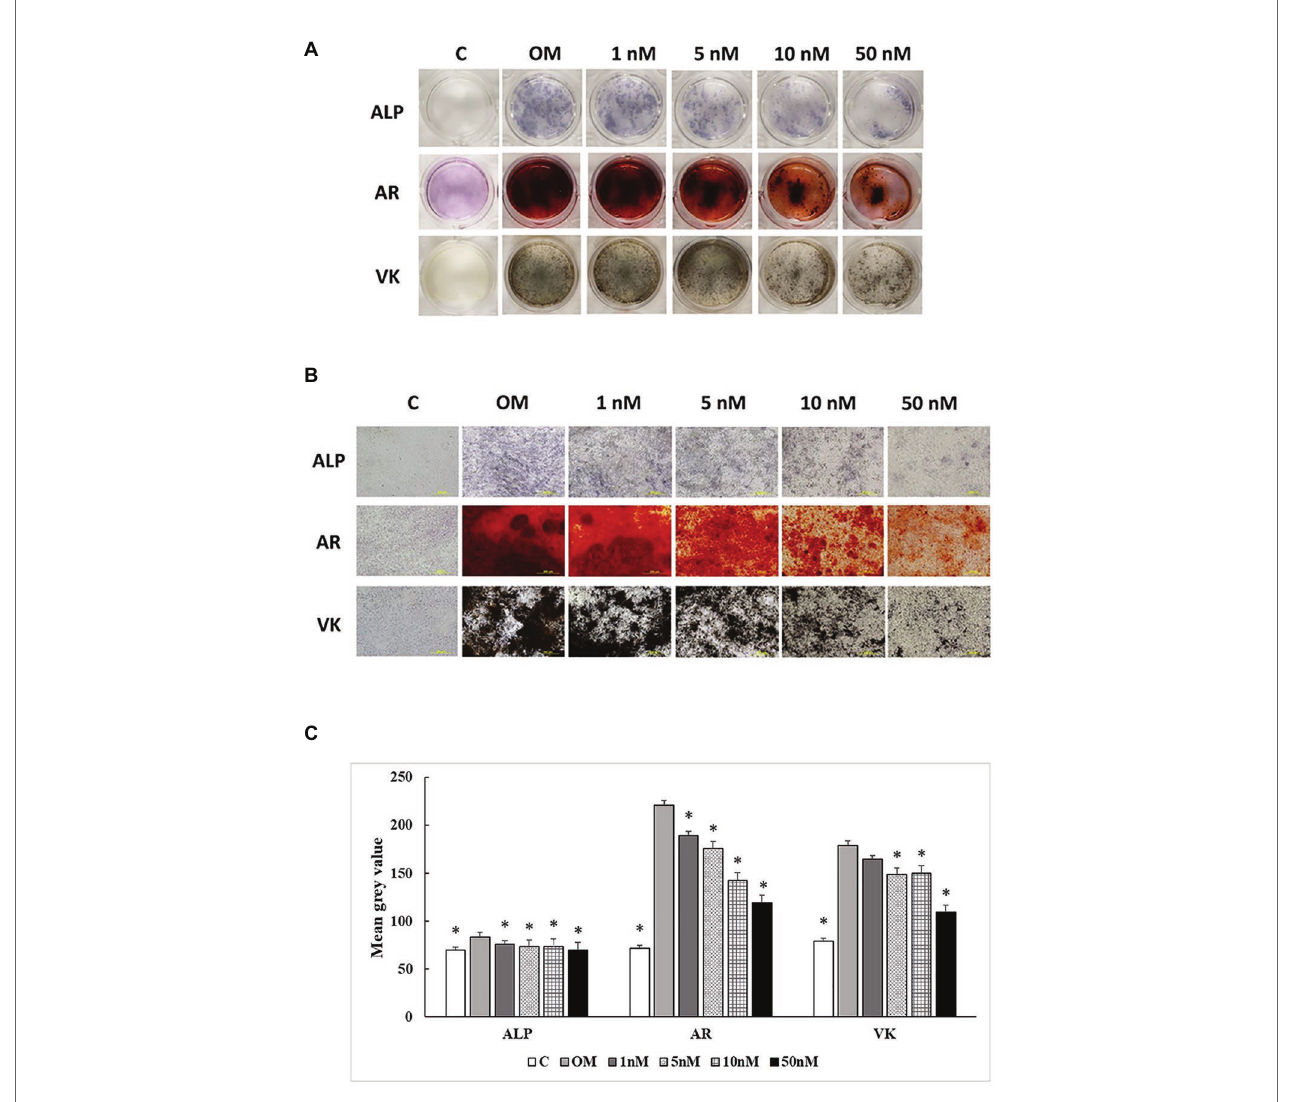
FIGURE 6 | Effects of 1,25OHD on chicken osteoblasts ALP activity and mineralization at 14 days. In each picture, the first row: ALP (Alkaline Phosphatase); the second row: AR (Alizarin Red stains the deposited minerals); and the third row: VK (Von Kossa stains for the deposited minerals). (A) Pictures were taken by DSRL camera, with same exposure setting across all the treatment. (B) The picture was taken under the microscope at 40x. The bar indicated 200 μ m. (C) The pictures (40x) were invert and converted to 8-bit gray scale using Image J software (1.48v version, U. S. National Institutes of Health, Bethesda, MD, United States). The mean gray value (0.16 mm 2 area) was measured. The values were presented as mean gray value. The higher value represents darker staining (Value means ± SEM, three replicates/treatment; * means significant difference compared to OM; ALP: p = 0.0022; AR: p < 0.0001; VK: p <